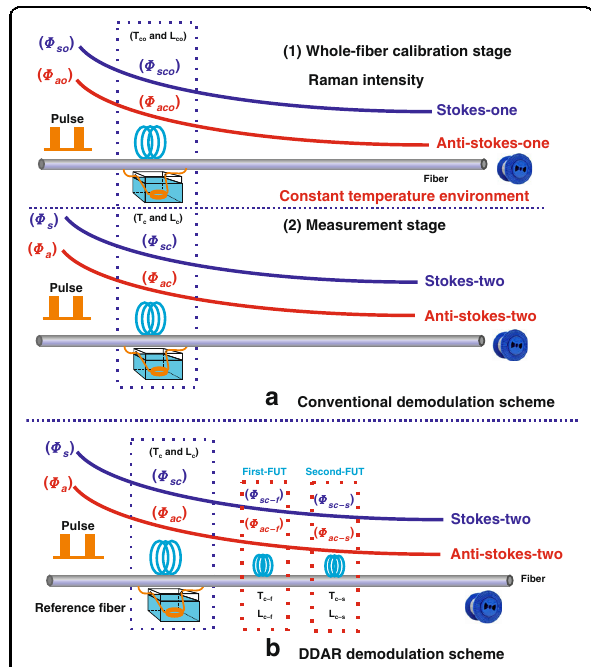
Fig. 6 Demodulation principles and schemes of the distributed optical fi ber sensors. a Schematic diagram of conventional demodulation scheme. b Schematic diagram of dynamic difference attenuation recognition scheme.